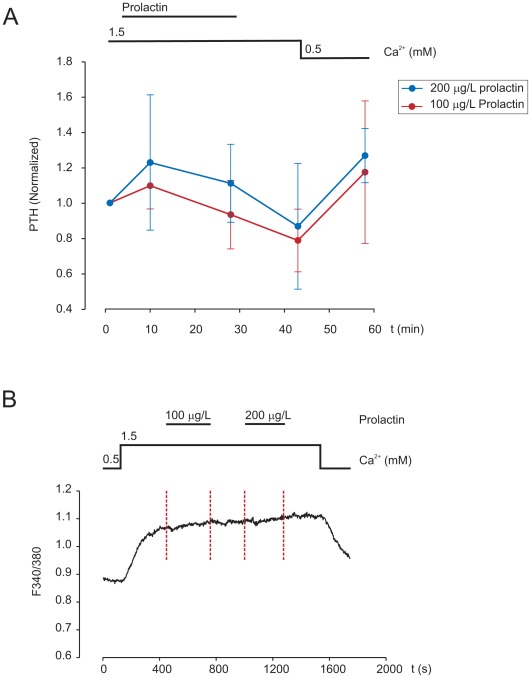
Analysis of PTH secretion and intracellular Ca2+ after prolactin treatment.A) Measurements of PTH secretion from parathyroid adenoma cells upon treatments with prolactin at 100 µg/L or 200 µg/L. Results from four independent experiments are shown. B) Example of a measurement of intracellular Ca2+ in parathyroid adenoma cells treated with 100 µg/L followed by 200 µg/L prolactin, as indicated by vertical red lines.